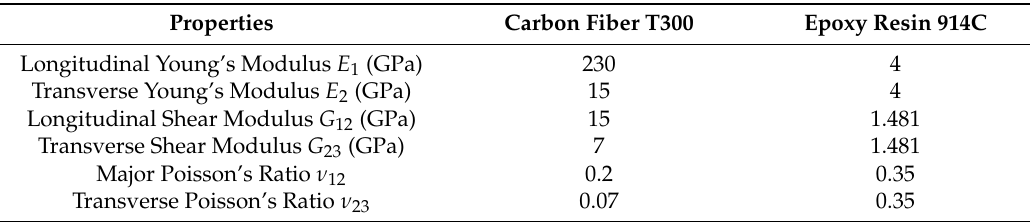
Table 1. Elastic properties of T300 carbon fiber and 914C epoxy resin